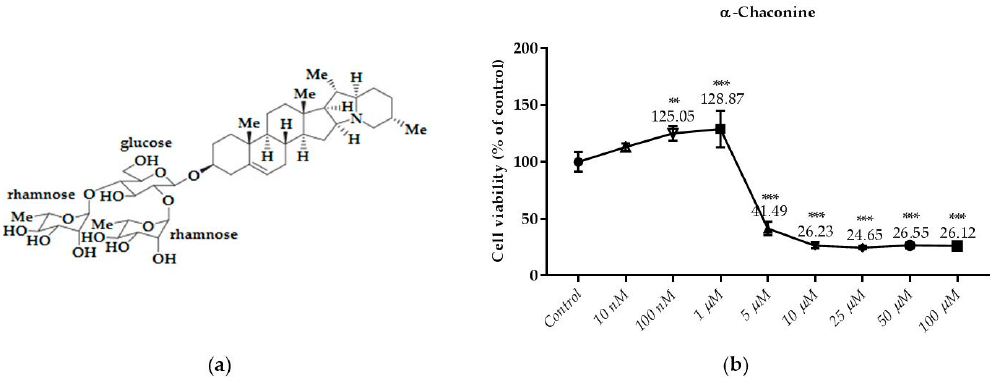
Figure 5. Dose dependent cytotoxic effects of α -chaconine was determined by SRB assay and shown for 24 h: ( a ) The molecular structure of α -chaconine; ( b ) Effect of α -chaconine on viability of RL95-2 cell. Cells were treated with various concentrations of α -chaconine for 24 h. Cell viability is presented as mean ± SD at least three independent experiments. ** p < 0.01 and *** p < 0.001 compared with the untreated control.